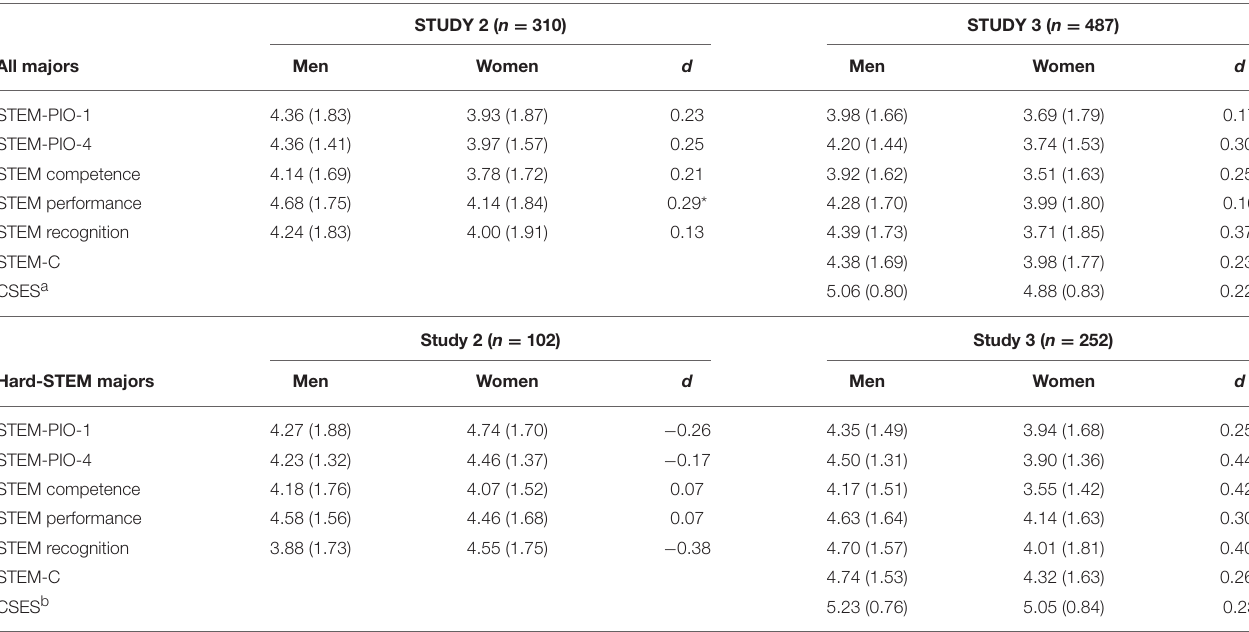
TABLE 5 | Differences in STEM identity by